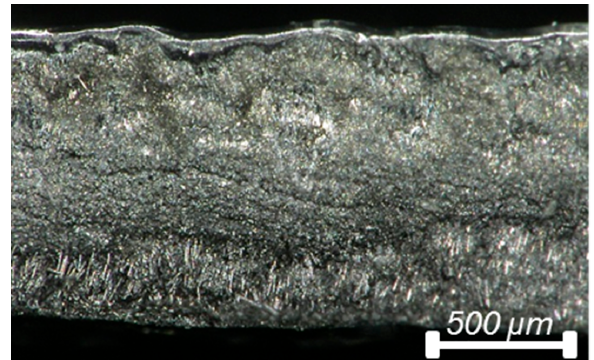
Figure 7. Microscopic view on a cut orthogonal to the direction of the fibers through a CFRP sample fabricated by process C from eight layers of carbon fibers and nine layers of PA foils, all 100 µm in thickness, resulting in 900 µm total thickness of the CFRP.